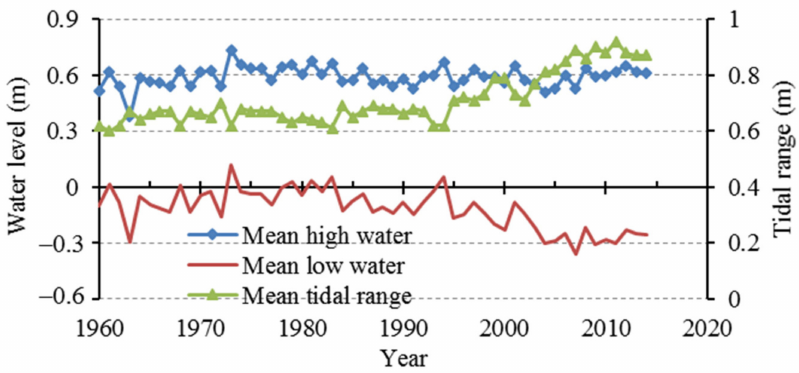
Figure 10. Water level and tidal range changes at Zhuyin station since